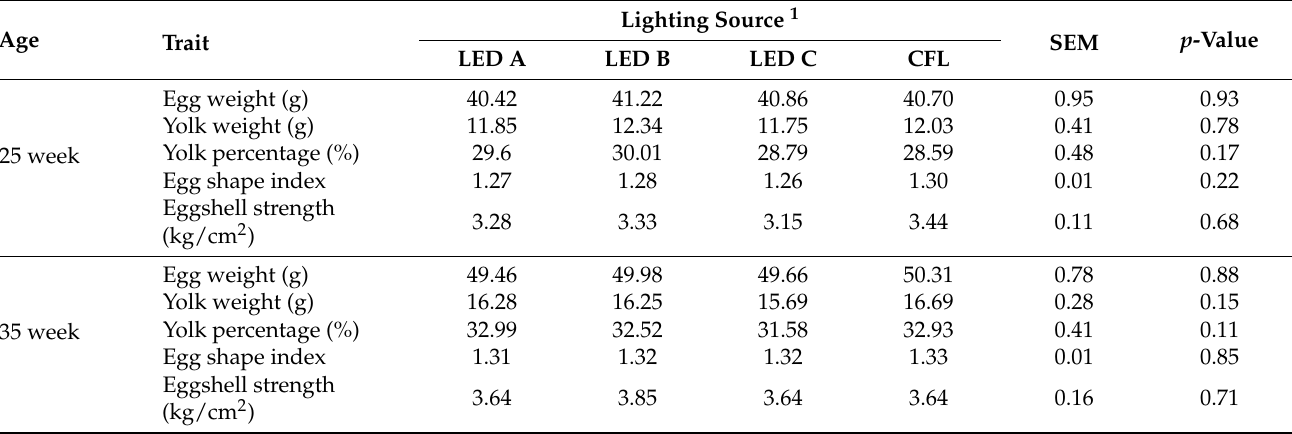
Table 7. Effect of lighting sources on egg quality traits of Beijing-You chickens at 25 and 35 week of